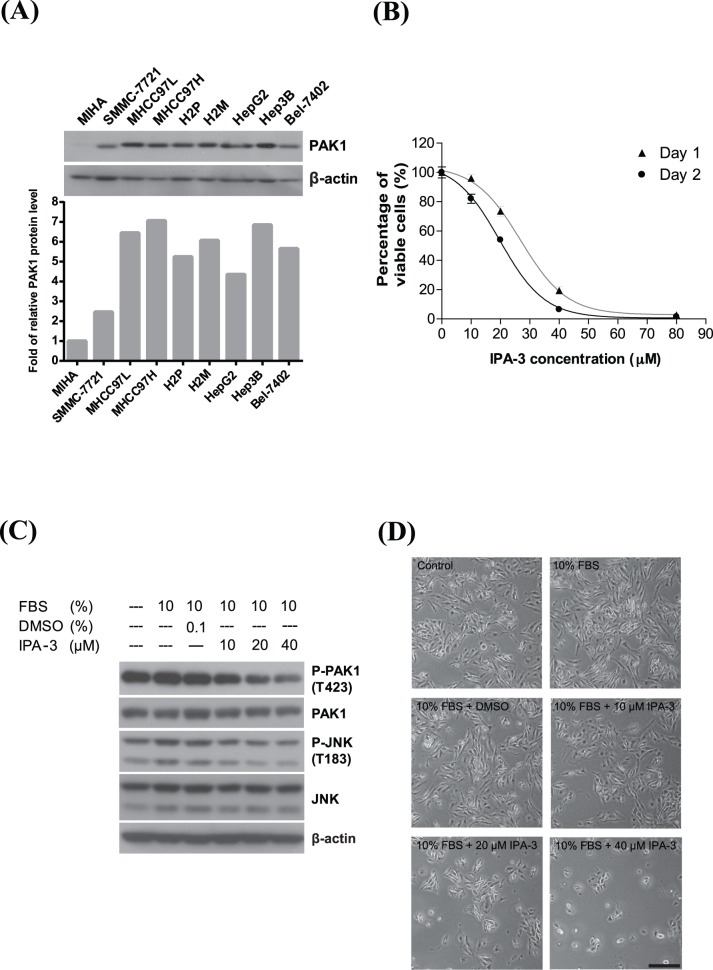
Inhibitory effect of IPA-3 on PAK1.(A) Relative protein levels of PAK1 in various cell lines. The signal intensities of the bands were quantified and normalized by taking that level of MIHA as 1. (B) MTT assay on Day 1 and 2. H2M cells (4×103) were seeded onto 96-well plates and treated with different dosages of IPA-3. The cells were harvested after incubation and the MTT assay was performed as mentioned in Material and Method. The graph showed the percentage of viable cells plotted against the dosage of IPA-3 (C) Western blotting analysis of the P-PAK1, total PAK1, P-JNK and total JNK. Serum-starved H2M cells were treated with either DMSO or IPA-3 at the indicated concentration for 15 minutes and followed by FBS replenishment and overnight culture. (D) H2M cells were serum-starved and treated with IPA-3 (10, 20 or 40 µM) in complete medium and allowed to grow overnight. The cell morphology images were captured at a magnification of 40X. Scale bar, 0.4 mm.